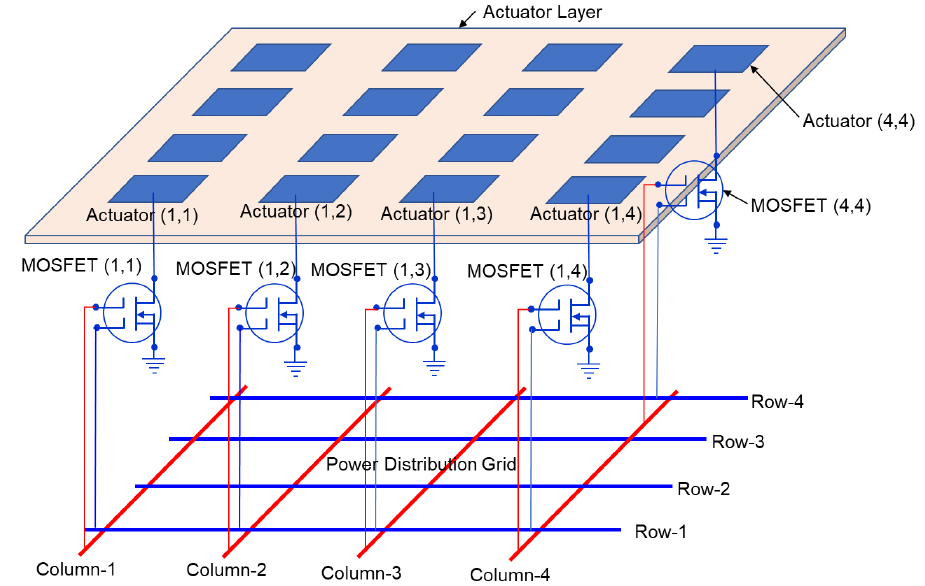
Figure 1. The physical construction of PD circuitry, including actuators.